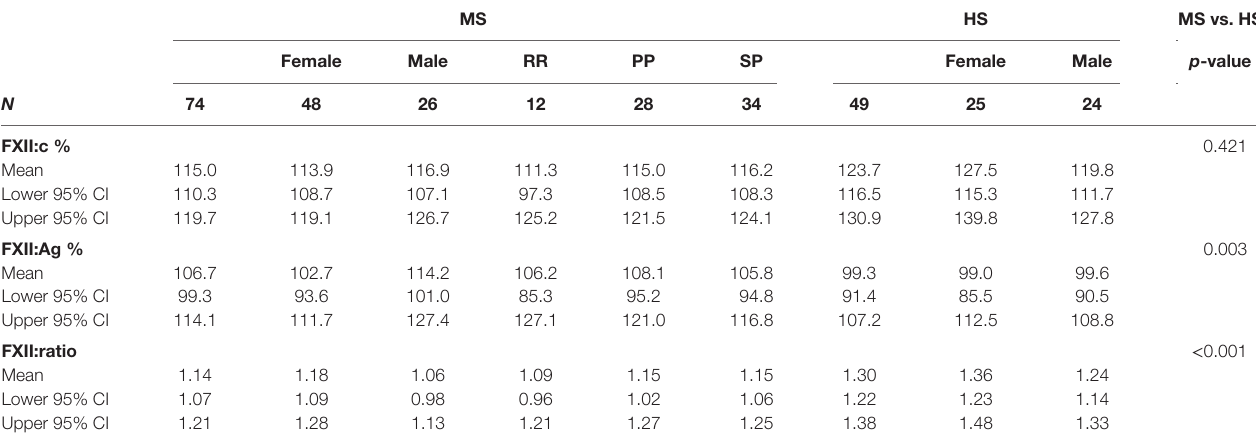
TaBle 2 | FXII activity, antigen, and ratio in MS patients and